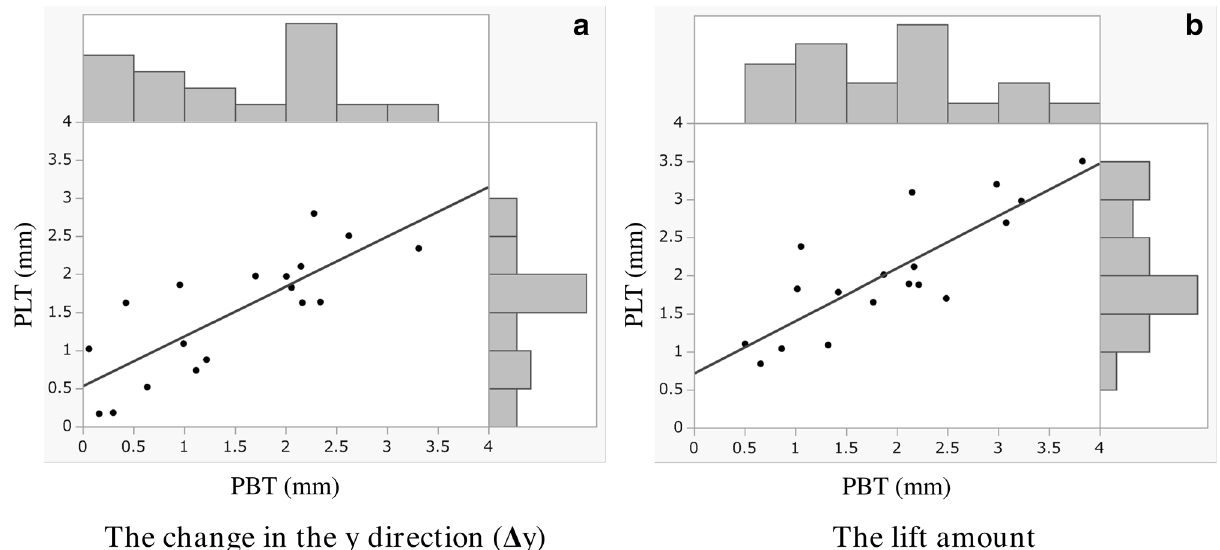
Figure 4. The scatter plot and histogram of ( a ) Δ y and ( b ) lift amount (LA) between the PLT and PBT (the plots were created using JMP Pro [SAS Institute Inc., Cary, NC, USA]). Approximately straight lines are shown as the eye guide. The LA was calculated by using the following formula: LA = (cid:31) (cid:31) x 2 + (cid:31) y 2 + (cid:31) z 2 . PLT peroneus longus tendon, PBT peroneus brevis